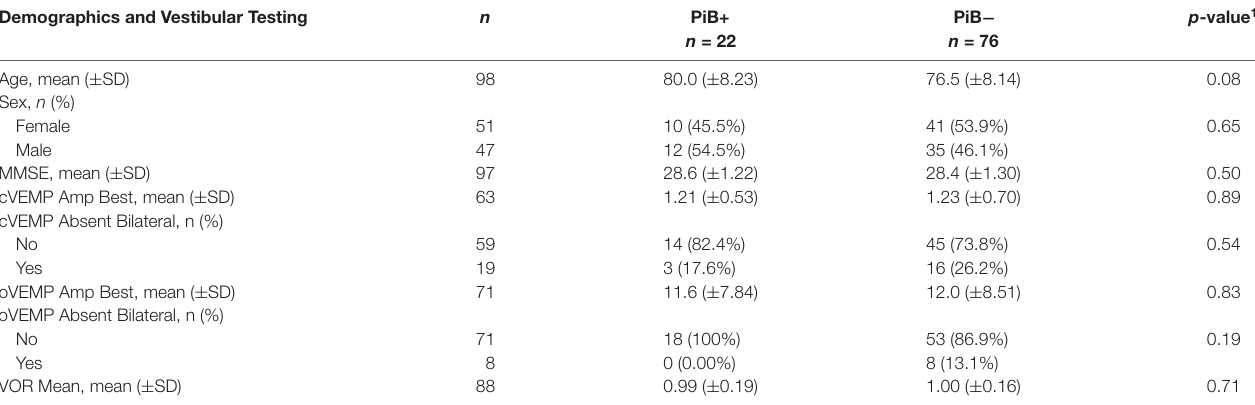
TABLE 1 | Demographics and Vestibular Physiologic Testing by Pittsburgh Compound B (PiB) status. Demographics and Vestibular Testing